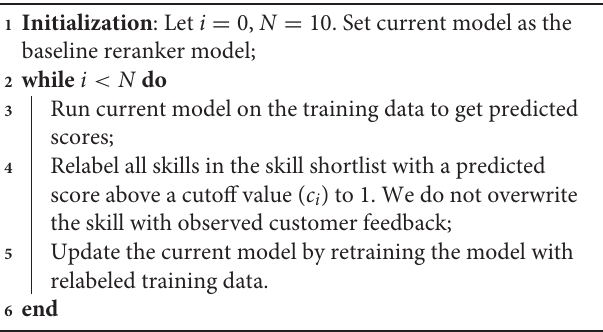
Algorithm 1: Self-training